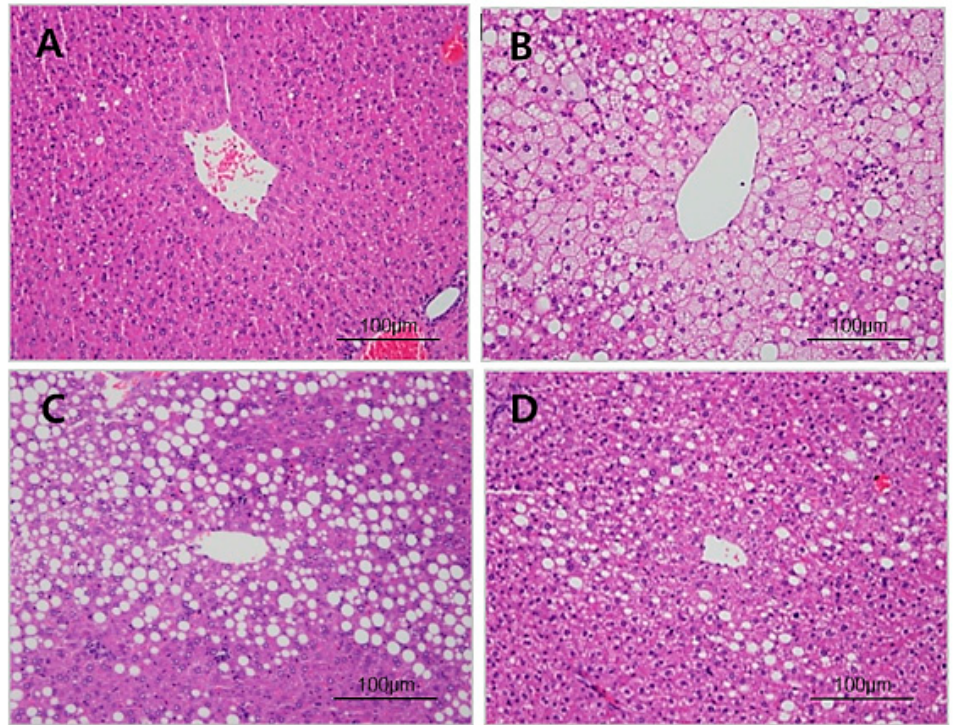
Figure 3. Histology of liver section. Histological examination ( × 100) in rat liver of ( A ) NDC (normal diet control group), ( B ) HDC (high-fat diet control group), ( C ) ORC (high-fat diet plus L-ornithine 20 mg / kg), and ( D ) KLAB (high-fat diet plus 1 × 10 9 CFU of L. brevis